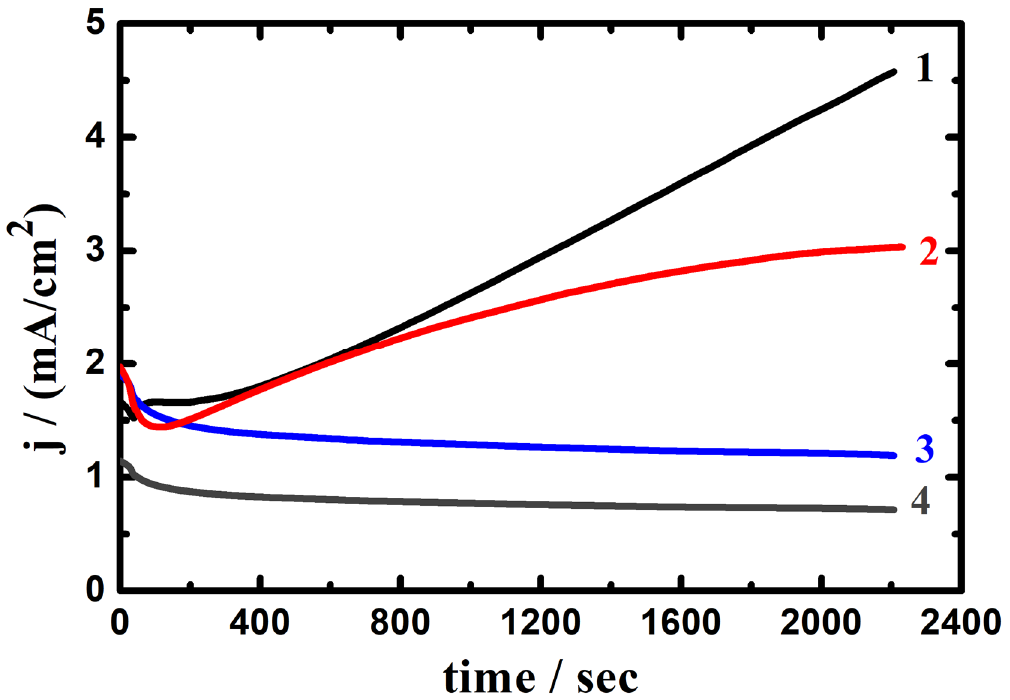
Figure 14. The change in current with time curves collected at −250 mV (Ag/AgCl) for (1) CrFeCuMnNi; (2) CrFeCuMnNi-3 vol.% Al 2 O 3 ; (3) CrFeCuMnNi-3 vol.% Y 2 O 3 ; and (4) CrFeCuMnNi-3 vol.% TiO 2 after their immersion in 3.5% NaCl solutions for 40 min.